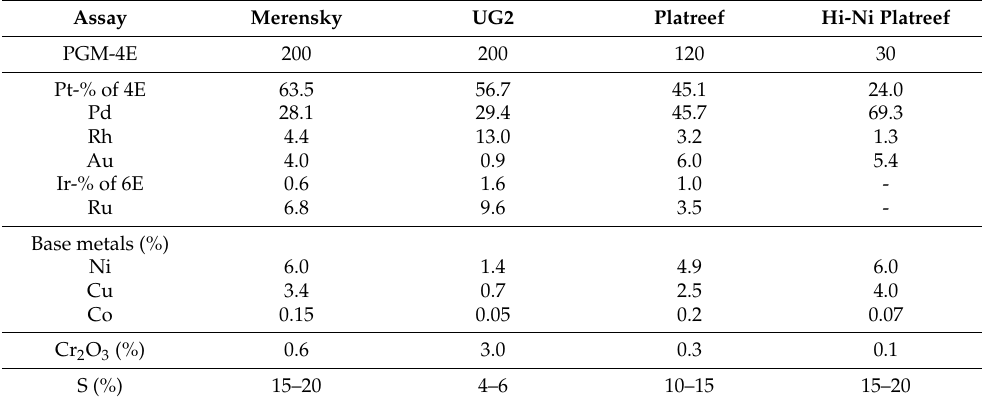
Table 1. PGM assays from different sources, with normalised analysis of the four precious elements (4E) and of Ir and Ru with respect to the 6E [24].